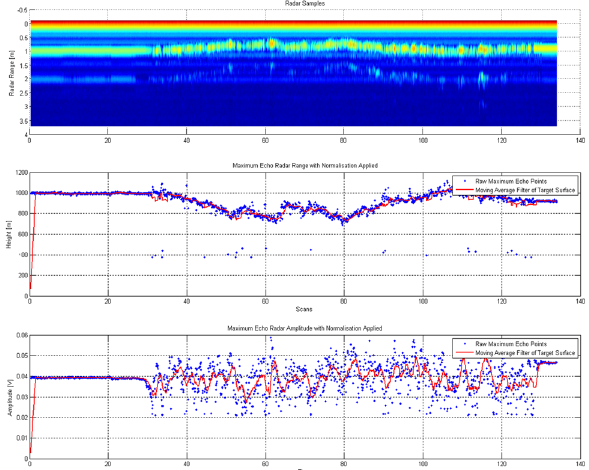
Fig. 11 Laser-reconstructed view of a detailed roof section with meshing